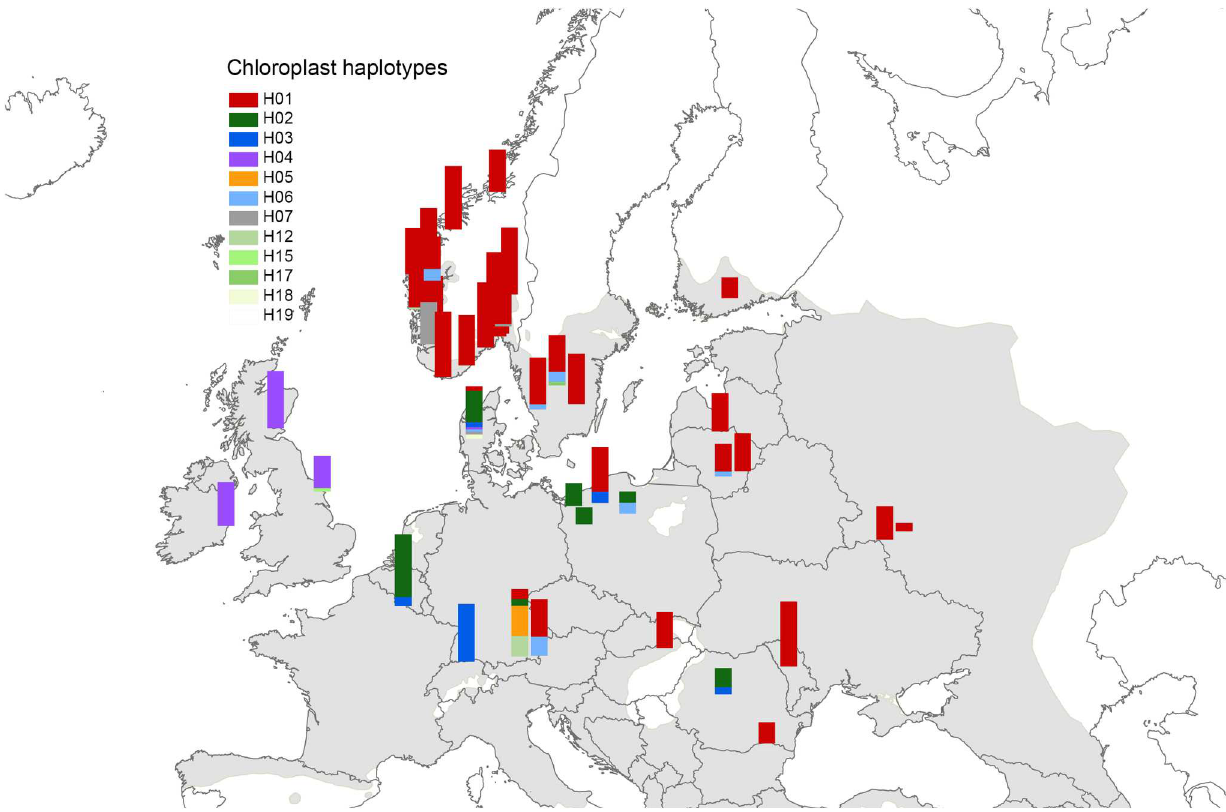
Fig 1. Distribution of chloroplast haplotypes in 42 common ash ( Fraxinus excelsior )population samples. Coding of the haplotypes follows Heuertz et al . [41] and Sutherland et al . [33], except for the novel haplotypes H17, H18 and H19. The definitionsof the haplotypes are given in Table 1. The shadedgray areas representthe natural distributionrange of common ash [29].